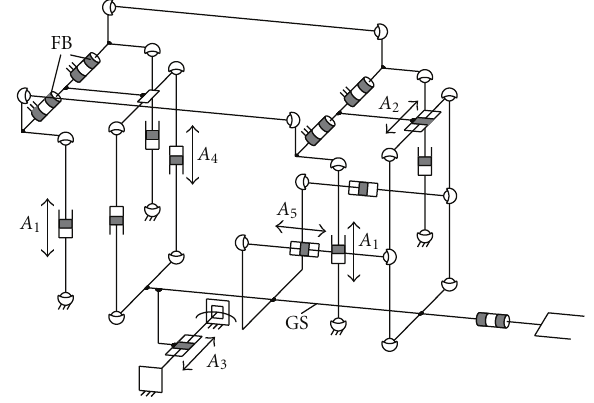
Figure 2: Geometric configuration of the serial-parallel forging